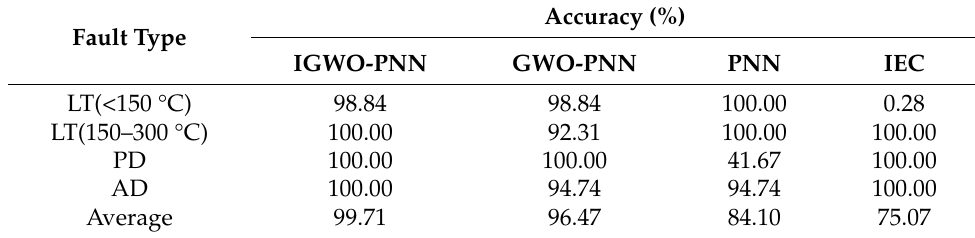
Table 5. Results of the first set of comparative experiments.